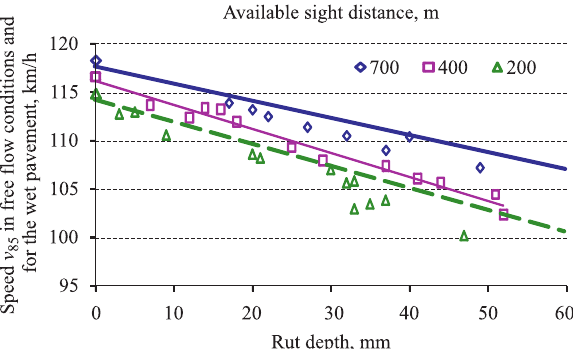
Fig. 5. Dependence of the speed v 85 on the rut depth for the level and straight-ahead road fragments with benchmark bendiness 5 �/km and at various available sight